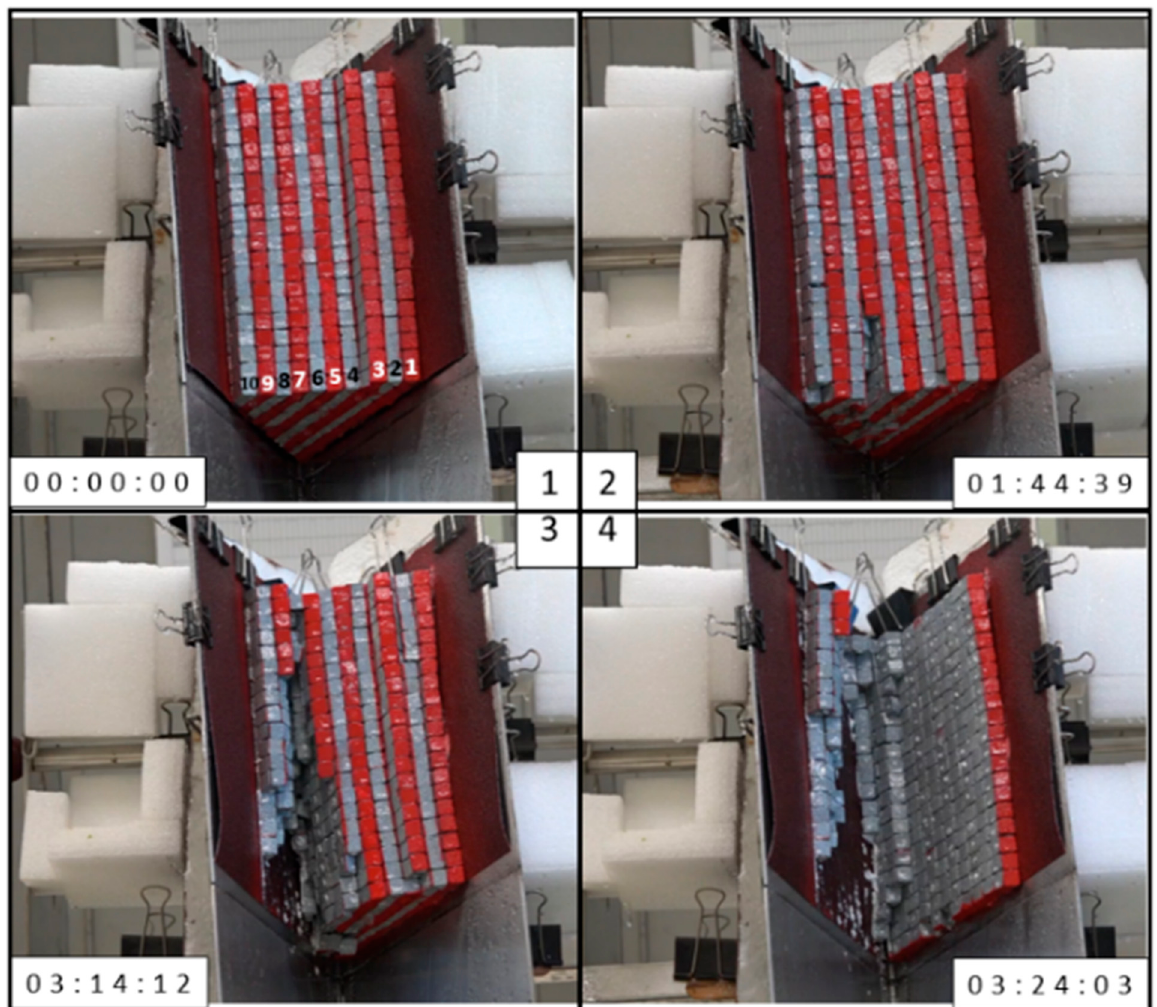
Figure 10. Physical Model E ( i a = 70° and ω 1 = ω 2 = 25°). The primary conditions of Model G were i a = 60 ◦ , ω 1 = 40 ◦ , and ω 2 = 10 ◦ , with two ec- centric half-wedge angles, and the duration of the test was 3 h 24 min 03 s (Figure 12). At the initial deformation stage under conditions of surface water infiltration (00:00:00–02:19:25), the model’s center of gravity was on the left plate (the side with a gentler slope), where ω was greater. In addition, the greater intersection angle meant that gravity exerted a greater impact on the model from the onset. As the surface water continued to infiltrate the model, it began to weaken and gradually deform and slide toward the toe on the left plate, leaving most of the rock on the left plate under compression, while most of the rock on the steep right plate was under tension. Before the midpoint of the test, rock continued to fall from the bottom of the model, resulting in local vertical torsion and displacement at locations No. 2 and No. 3. Weakened by water, the entire tock mass gradually slid and deformed. Next, the overall model reached the stage of local rock mass failure (02:19:26–02:33:32). Vertical torsion and displacement continued at locations No. 2 and No. 3 until tension cracks developed at location No. 8 (the cracks parallel to the intersection angle). The rock at locations No. 3–7 then lost its support on the sides, causing the rock mass to slide downwards along the intersection line, and only approximately 35% of the rock remained on the slope. The last stage is characterized by the rock wedge sliding and acceleration of the failure (02:33:33–04:00:51). After the collapse of the center rock mass, the rock at locations No. 9 and No. 10 remained on the slope. However, due to the loss of the rock on the intersection line, the rock remaining on the right plate gradually toppled toward